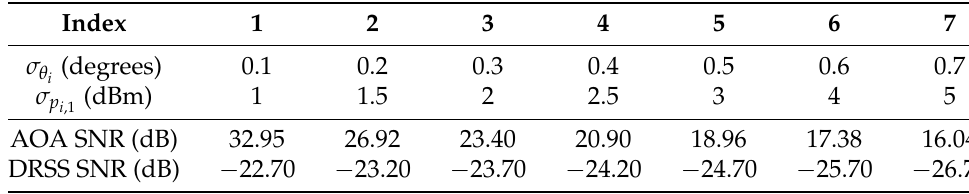
Table 1. Noise index for AOA/DRSS measurements.